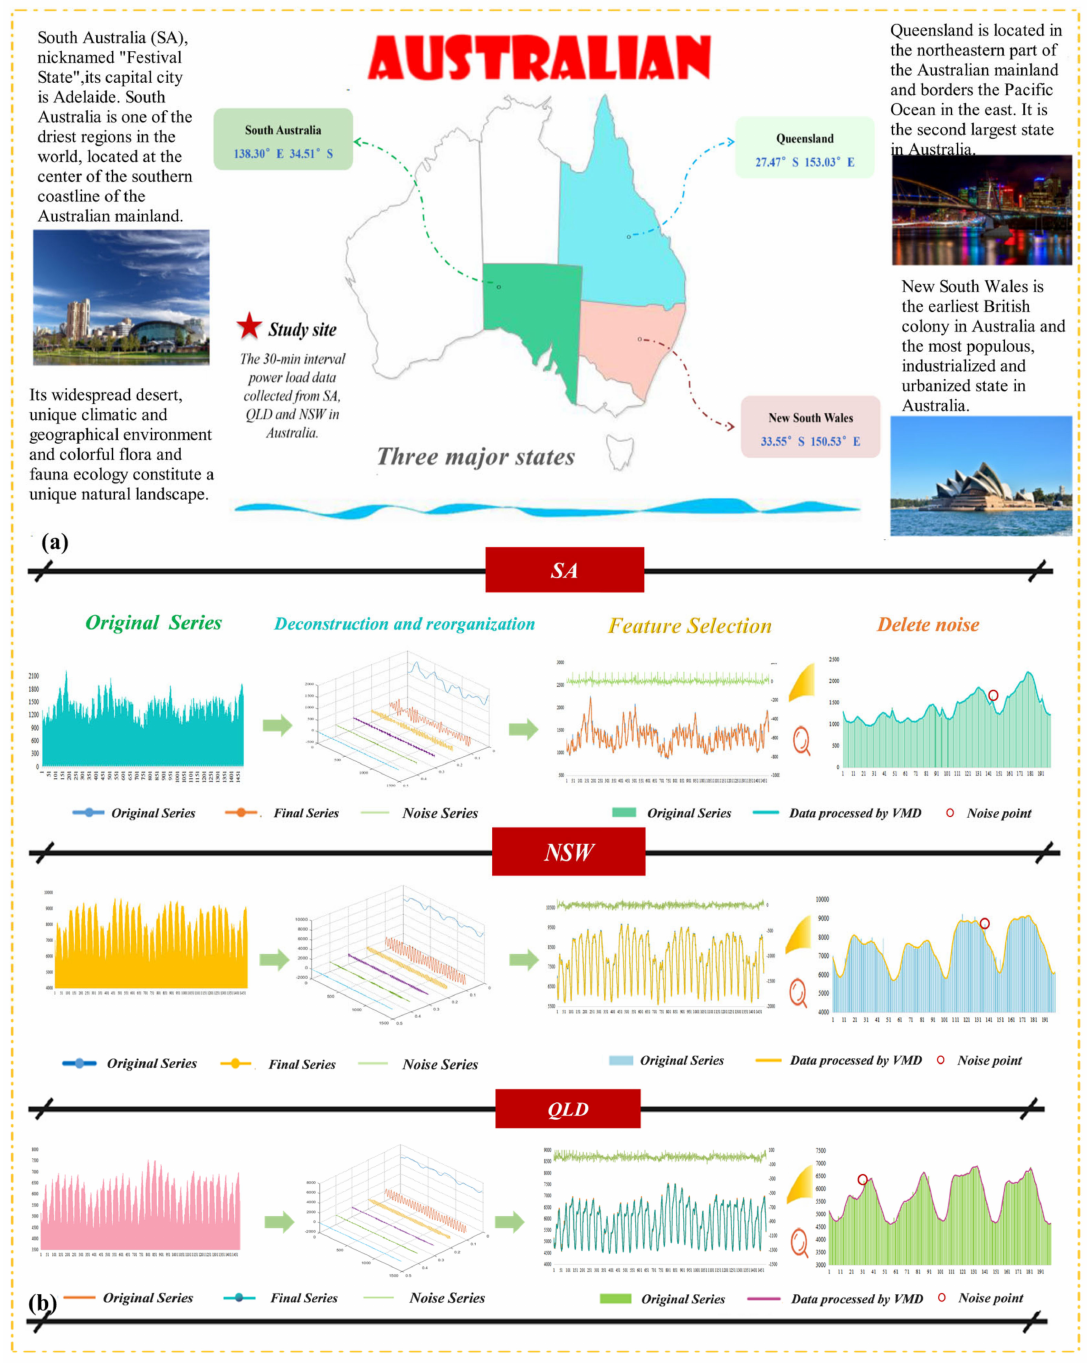
Figure 3. Site data and data preprocessing results. ( a ) the situation of the three study regions. ( b ) Data preprocessing